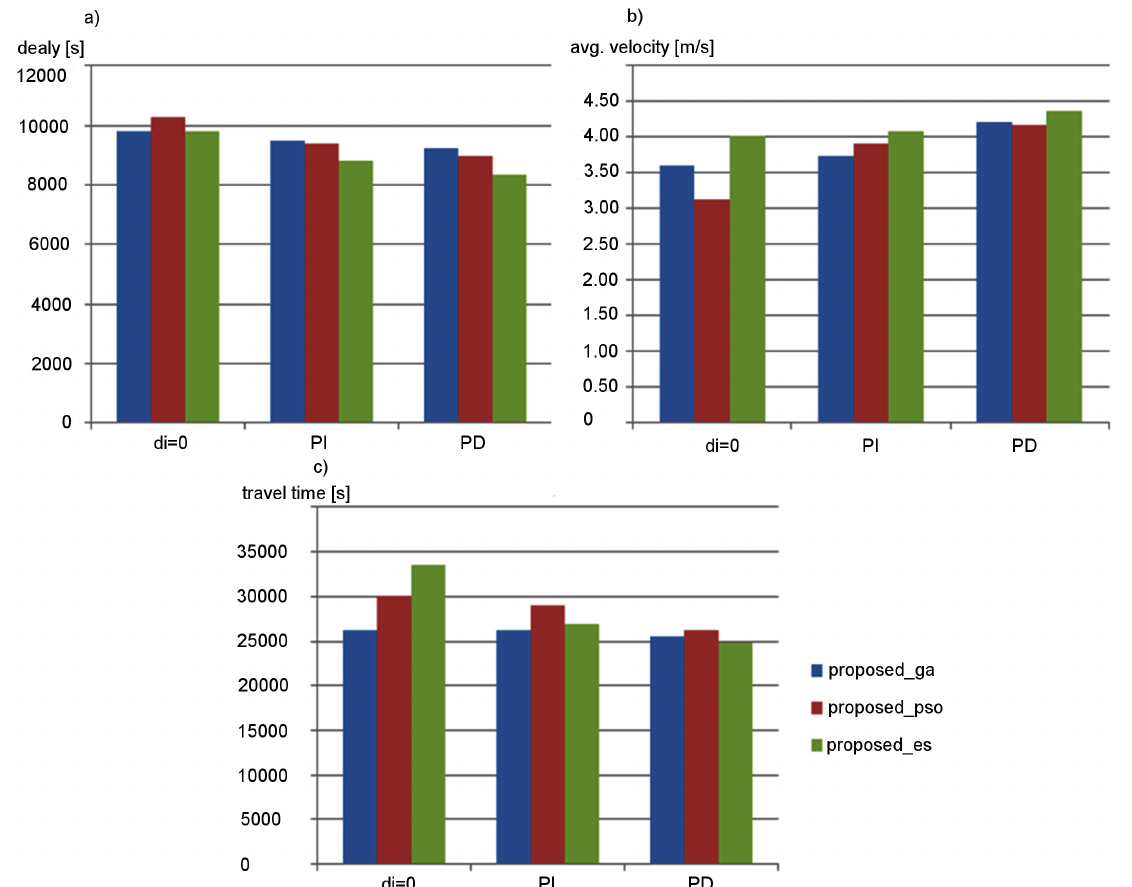
Figure 11. Effectiveness of proposed approach for different occupancy prediction methods: ( a ) delay; ( b ) average velocity; and ( c ) travel